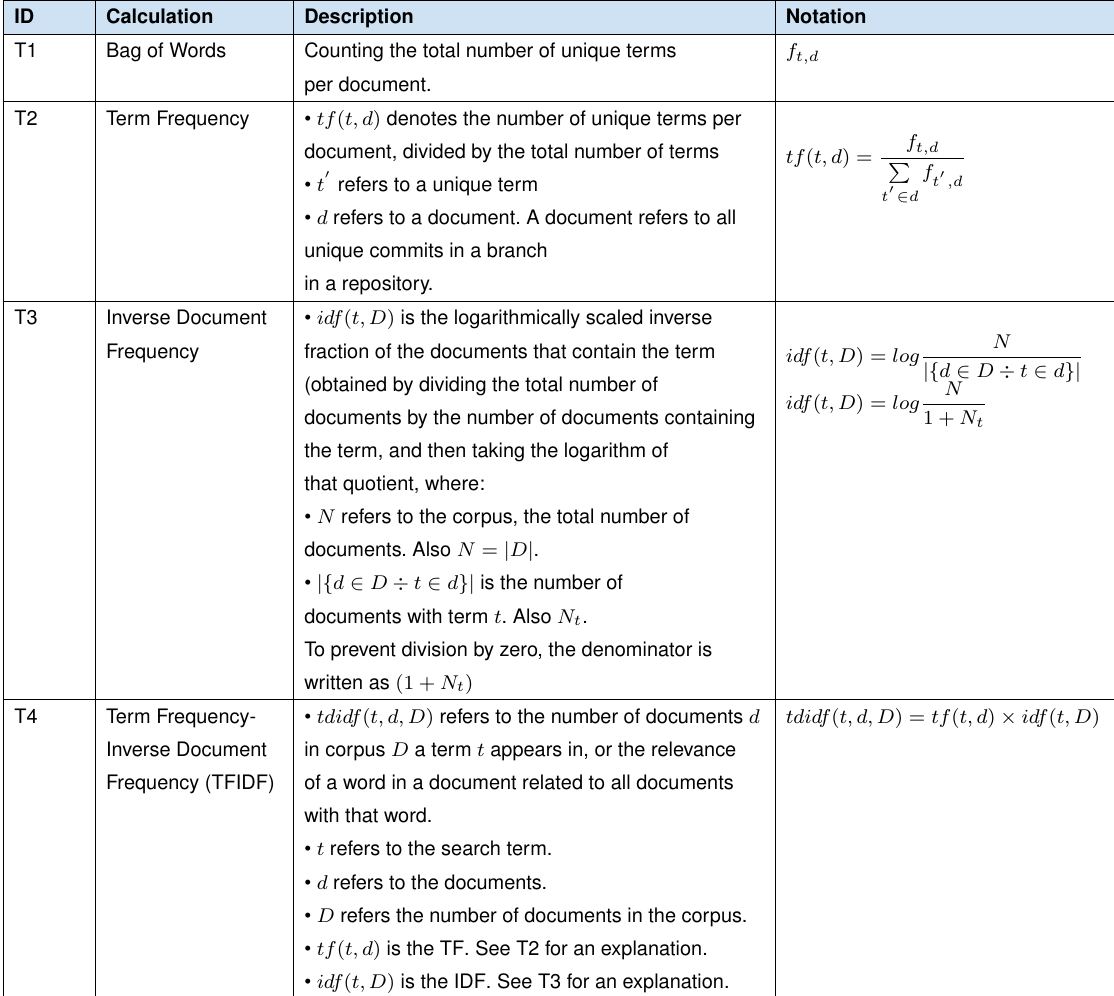
Table 5. Statistical methods for NLP and Text